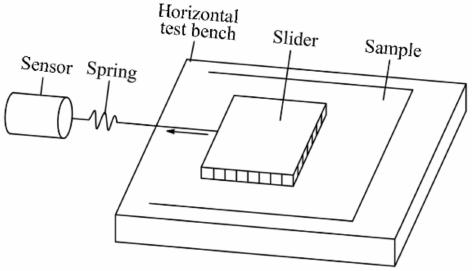
Figure 5. Schematic diagram of the friction coefficient test for the granular fungal fertilizer.